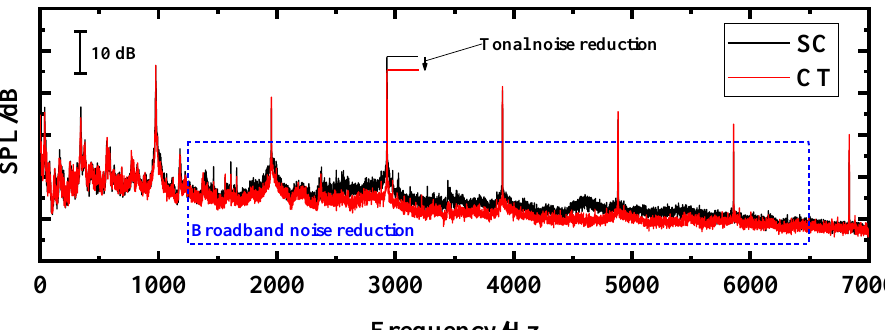
Figure 5. Noise spectrum of the compressor, with and without CT at DP.